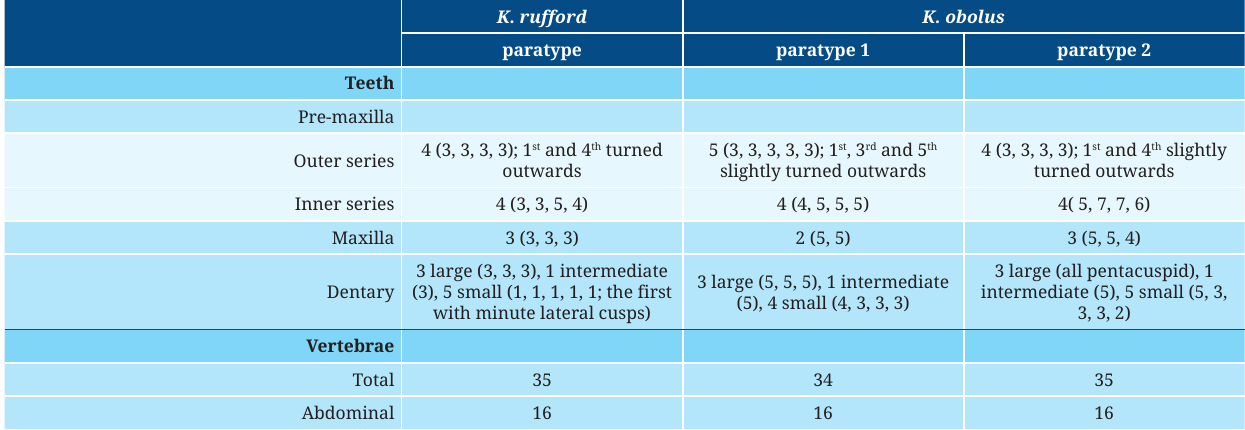
TABLE 2 | Meristic osteological characters of Knodus rufford (CPUFMT 6834) and K. obolus (CPUFMT 6837). Numbers in parenthesis after a tooth count represent the number of cusps, from medial to lateral. Counts of gill rakers given as follows: total value (rakers attached to pharyngobranchial; between pharyngobranchial and epibranchial; on epibranchial; between epibranchial and ceratobranchial;